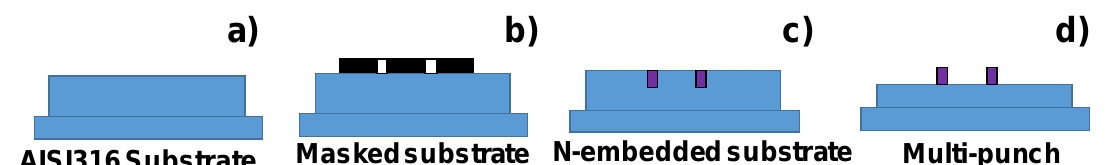
Figure 1. Plasma printing procedure in the present study. ( a ) The starting AISI316 substrate, ( b ) masked substrate by the screen printing, ( c ) nitrogen-embedded substrate by plasma nitriding, and ( d ) multi-punch formed by the blasting.